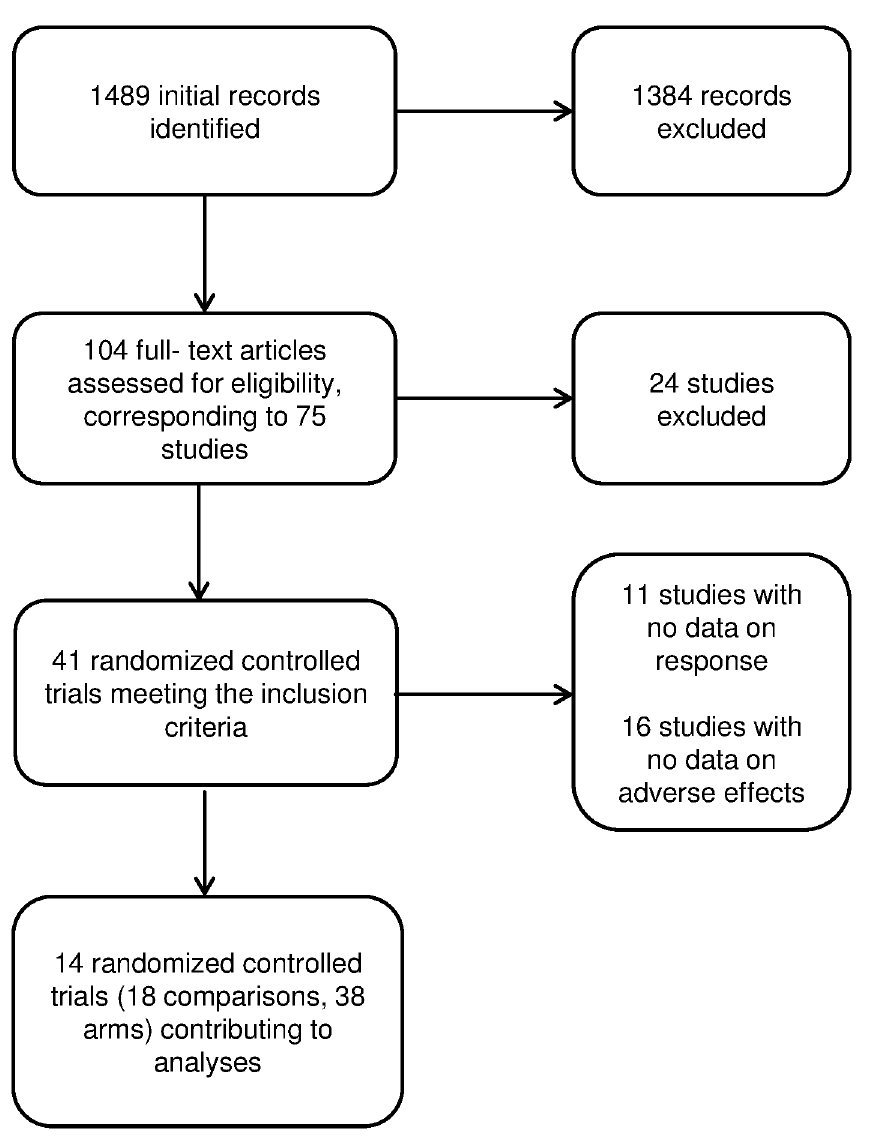
Fig 2. PRISMA flow